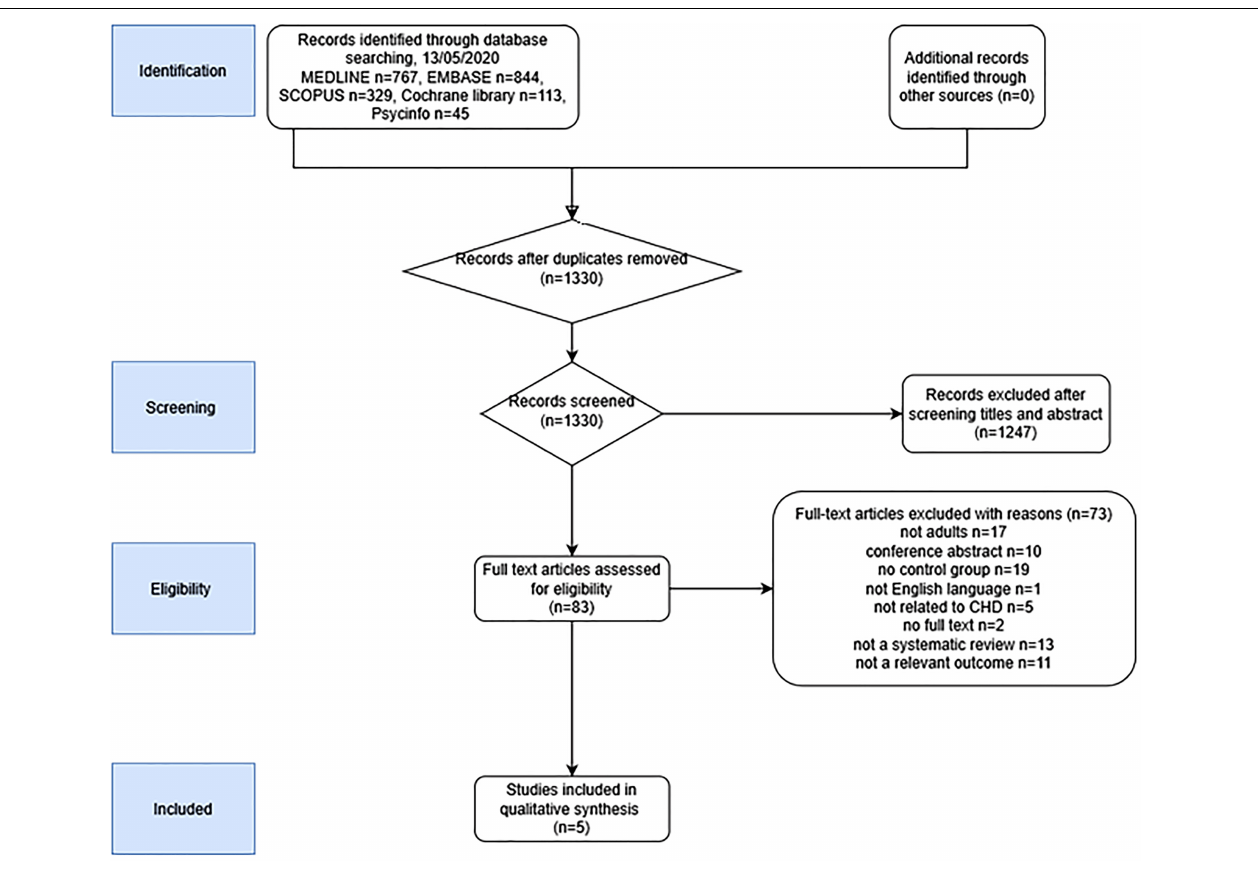
FIGURE 1 | PRISMA flow chart of articles